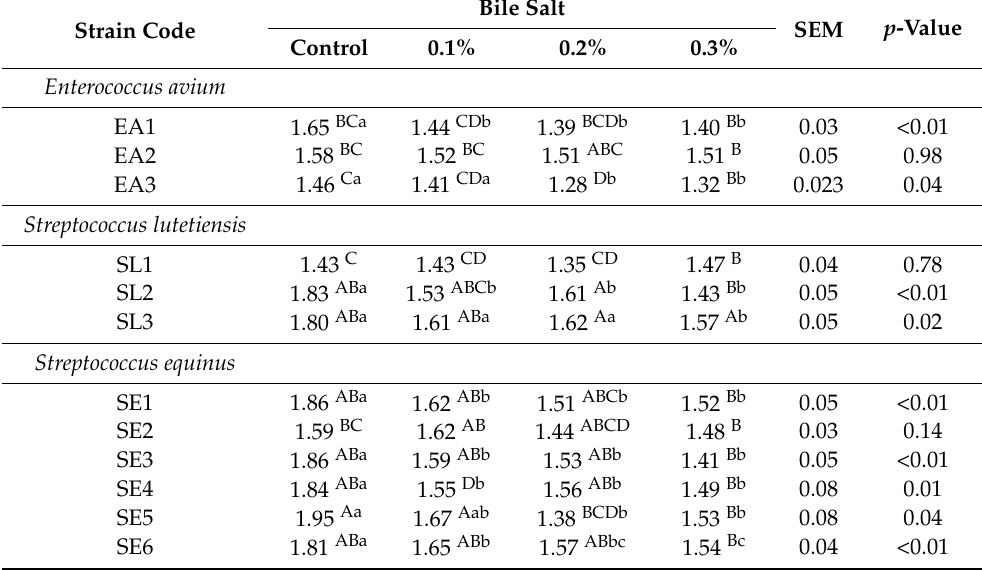
Table 3. Growth (OD600) of Enterococcus avium , Streptococcus lutetiensis and Streptococcus equinus cultures after 24 h of growth under different bile salt